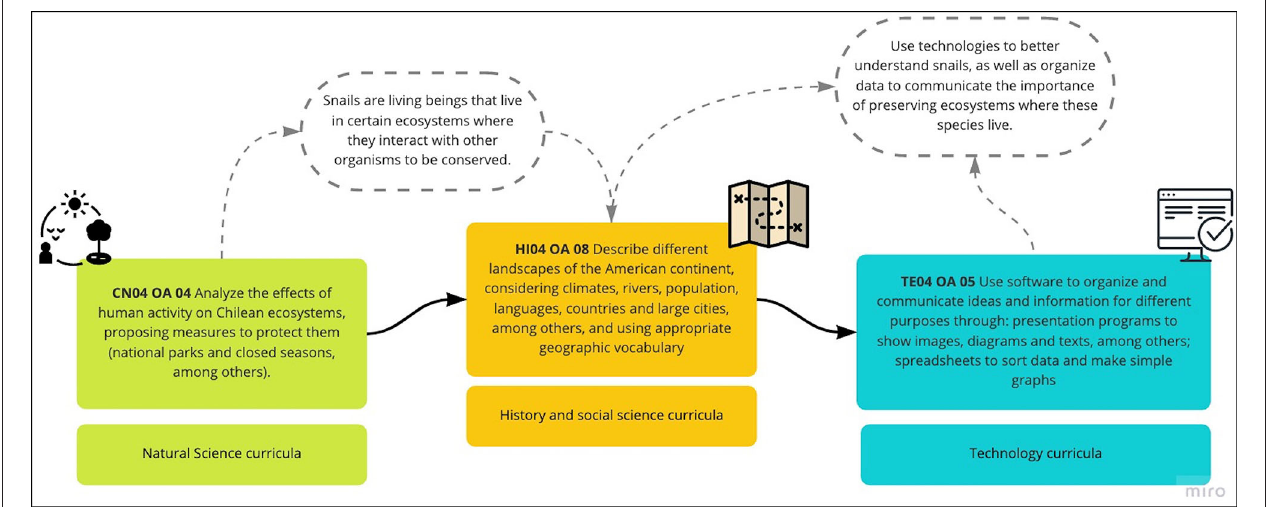
FIGURE 3 | Curricular mapping selected for the elaboration of a TLS mediated by augmented